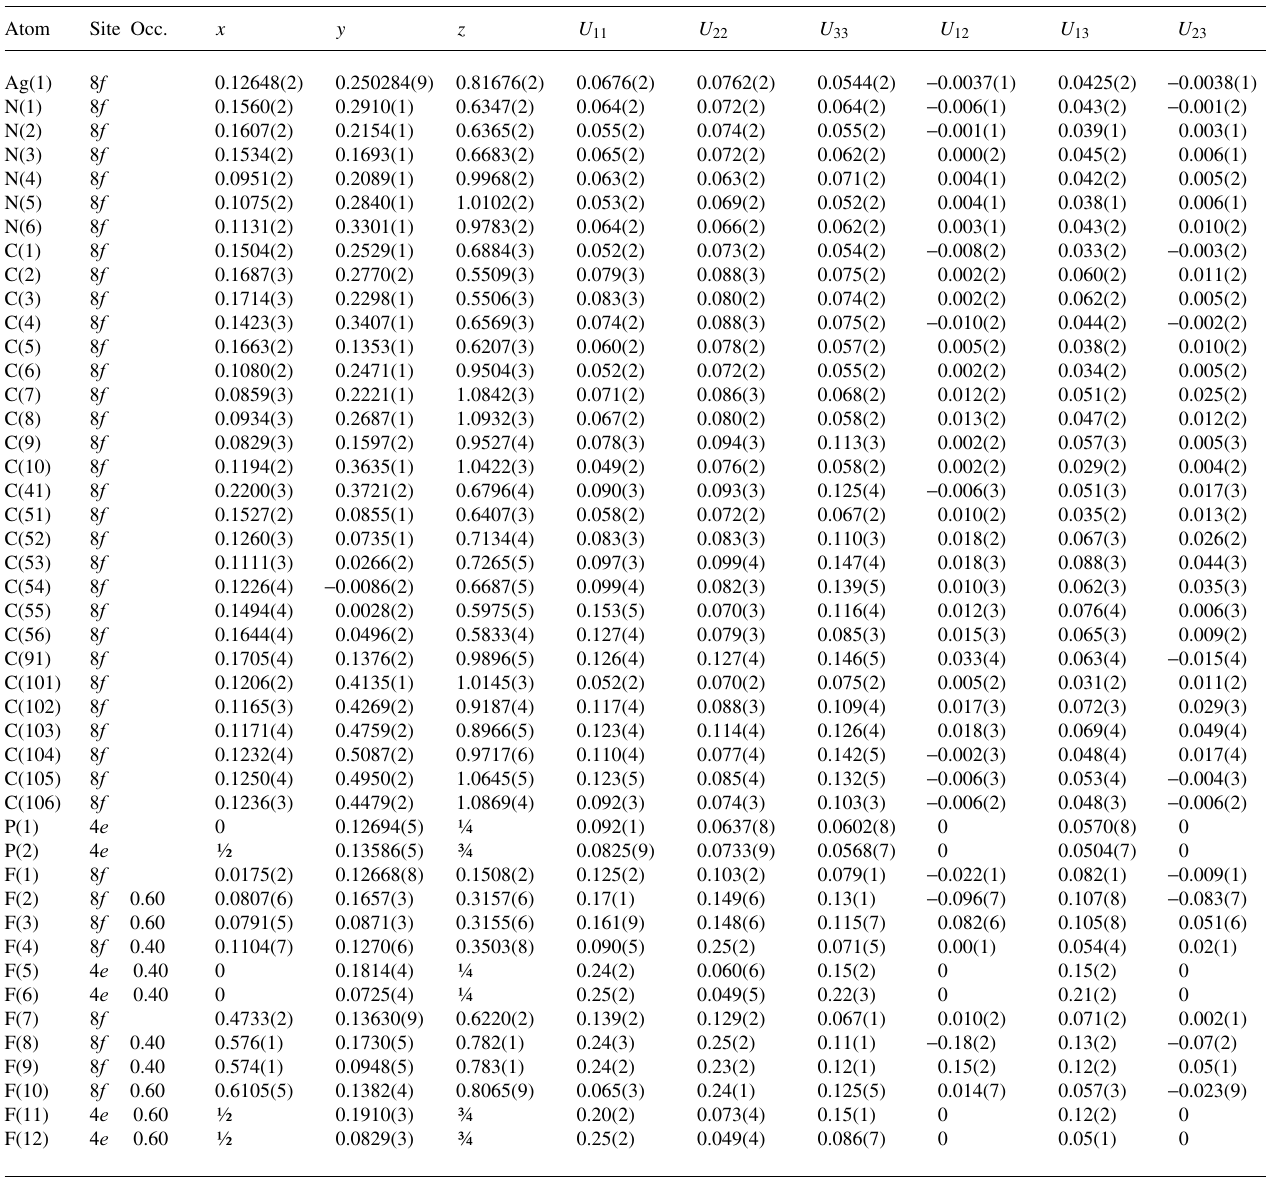
Table 3. Atomic coordinates and displacement parameters (in Å 2 ) . Atom Site